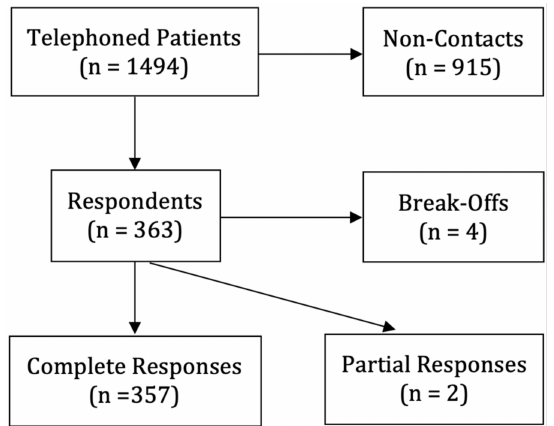
Figure 1. Sampled patients for